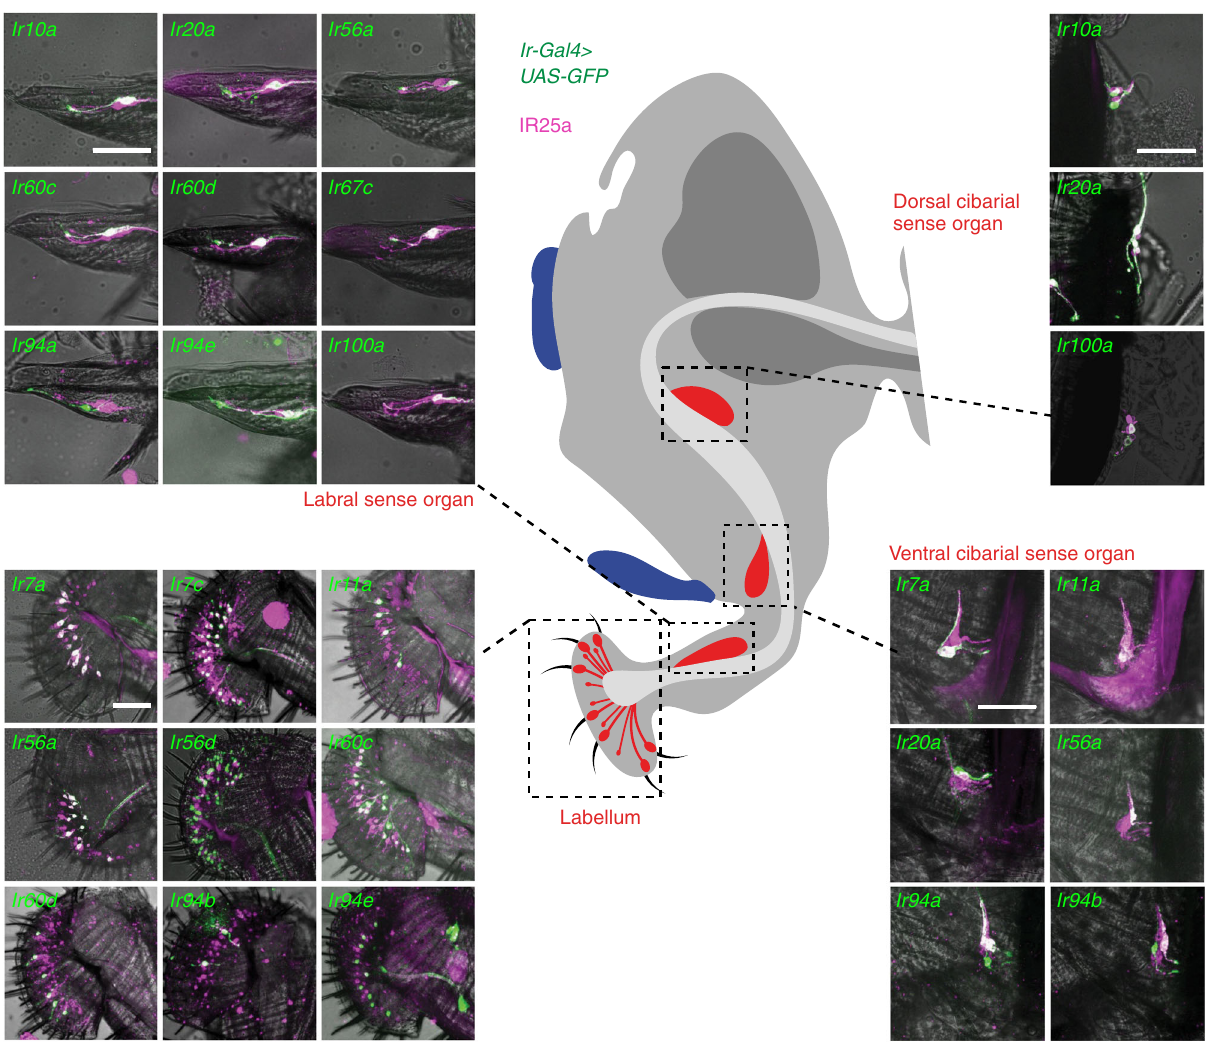
Fig. 3 Expression of Ir-Gal4 drivers in the proboscis of adult Drosophila . Immuno fl uorescence with anti-GFP (green) and anti-IR25a (magenta), overlaid on bright- fi eld images, on whole-mount proboscides revealing the expression of Ir-Gal4 lines in different adult gustatory organs (as schematised in the cartoon in the centre). Genotypes are of the form: w;UAS-mCD8:GFP;IrX-Gal4 . Scale bars: 50 μ